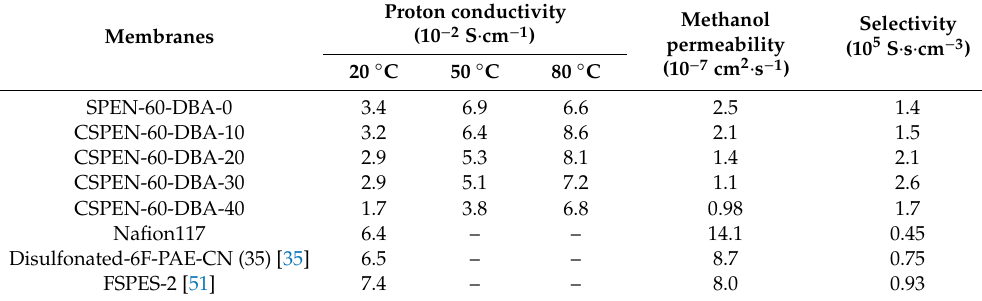
Figure 9. The proton conductivity of CSPEN-60-DBA-x at di ff erent temperatures. Table 3. The proton conductivity, methanol permeability, and selectivity of CSPEN-60-DBA-x at di ff erent